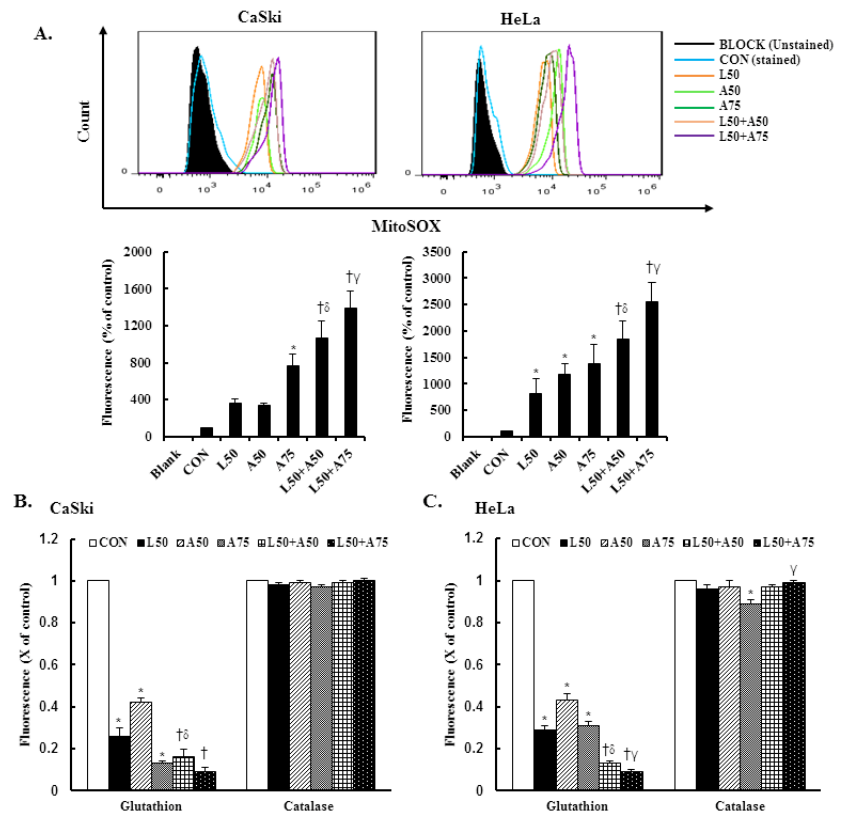
Figure 4. The combination of luteolin and asiatic acid upregulated mitoROS production and down- regulated GSH activation. CaSki and HeLa cells were treated with Lut (50 µ M) or AsA (50 and 75 µ M) alone or in combination for 24 h. ( A ) Flow cytometry was used to analyze the mitochondrial ROS level and quantitative results are presented in the lower plot. ( B , C ) GSH and catalase activation were analyzed using ELISA. Quantitative results are shown in the lower plot. Values represent mean ± SD from three replicates. *, †, δ and γ p ˂ 0.05 compared with CON, L50-, A50- or A75-treated group. CON, 0.1% DMSO; L50, 50 μ M luteolin; A50, 50 μ M asiatic acid; A75, 75 μ M asiatic acid. L50 + A50, 50 μ M luteolin + 50 μ M asiatic acid; L50 + A75, 50 μ M luteolin + 75 μ M asiatic acid. To investigate the cell migration ability of cervical cancer cell lines treated with Lut